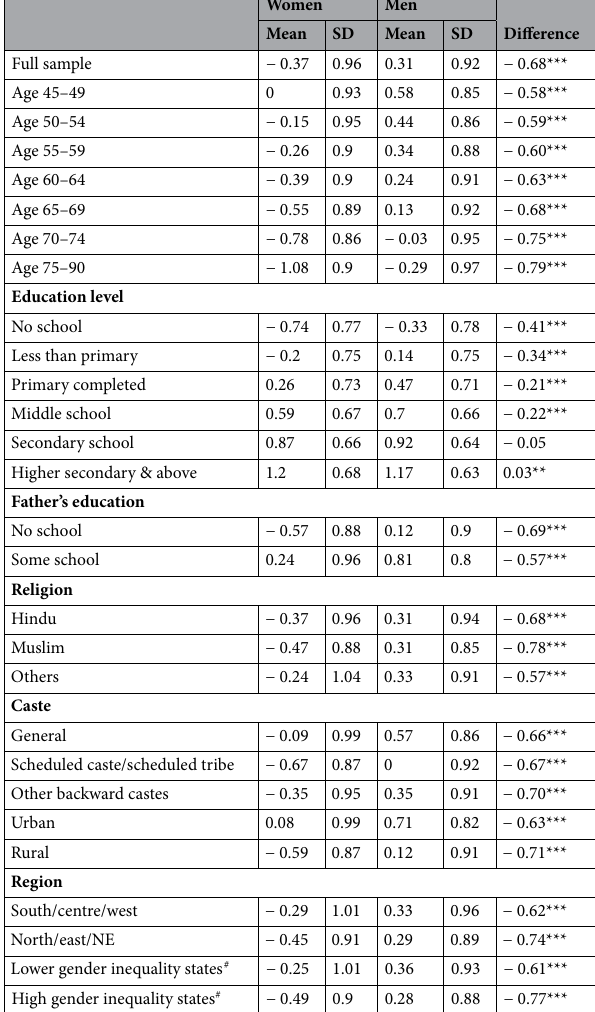
Table 2. Gender differences in cognition factor score among adults aged 45 and older in India. Data source Longitudinal Ageing Study in India (LASI), 2017–2019. All statistics are weighted. # Lower gender inequality states are those in the bottom quartile of the state-level gender inequality index (GII), high gender inequality states have GII in the top quartile. ***p < 0.01, **p < 0.05, *p <